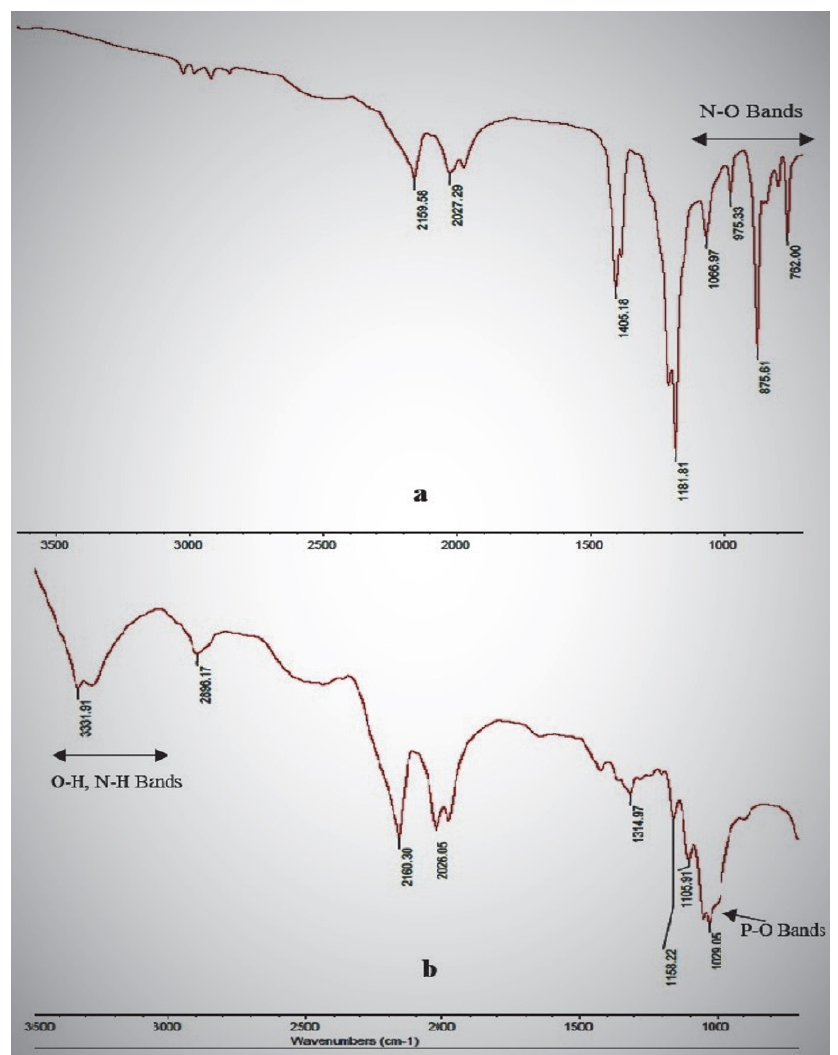
Figure 3. a . Nitrocellulose membrane (Blank) FTIR Transmittance Image, b. Membrane + Cmm ssDNA FTIR Transmittance Image.